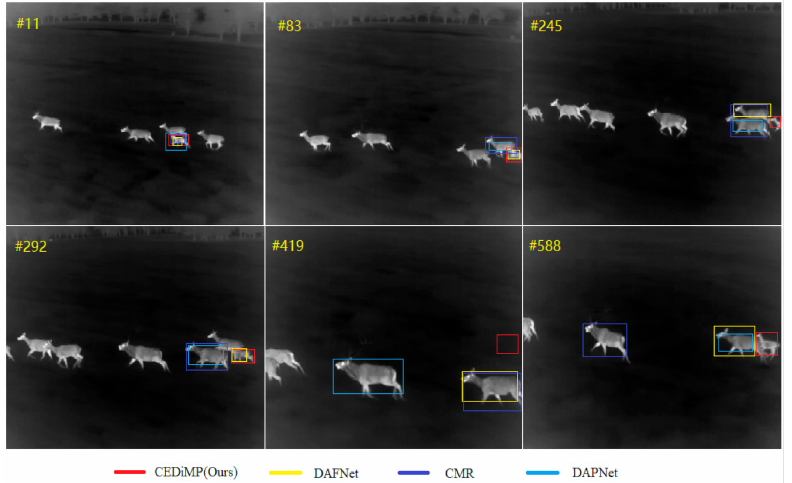
Figure 11. Qualitative comparison results of single TIR